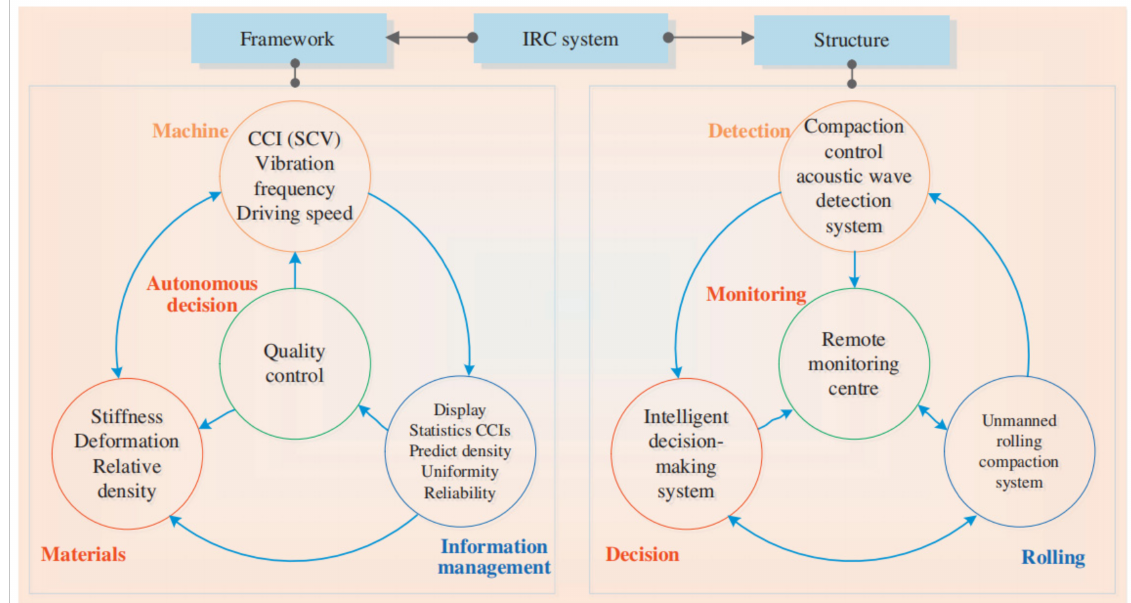
Figure 13. Framework and structure of the IRC system (reprinted with permission from Reference [17], copyright Elsevier,